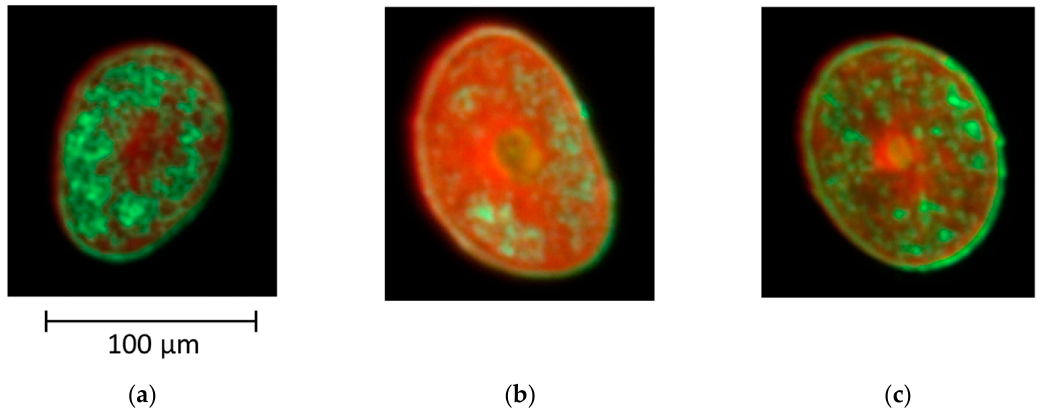
Figure 2. Fluorescently stained sections of three typical hairs having different bending modulus. ( a )